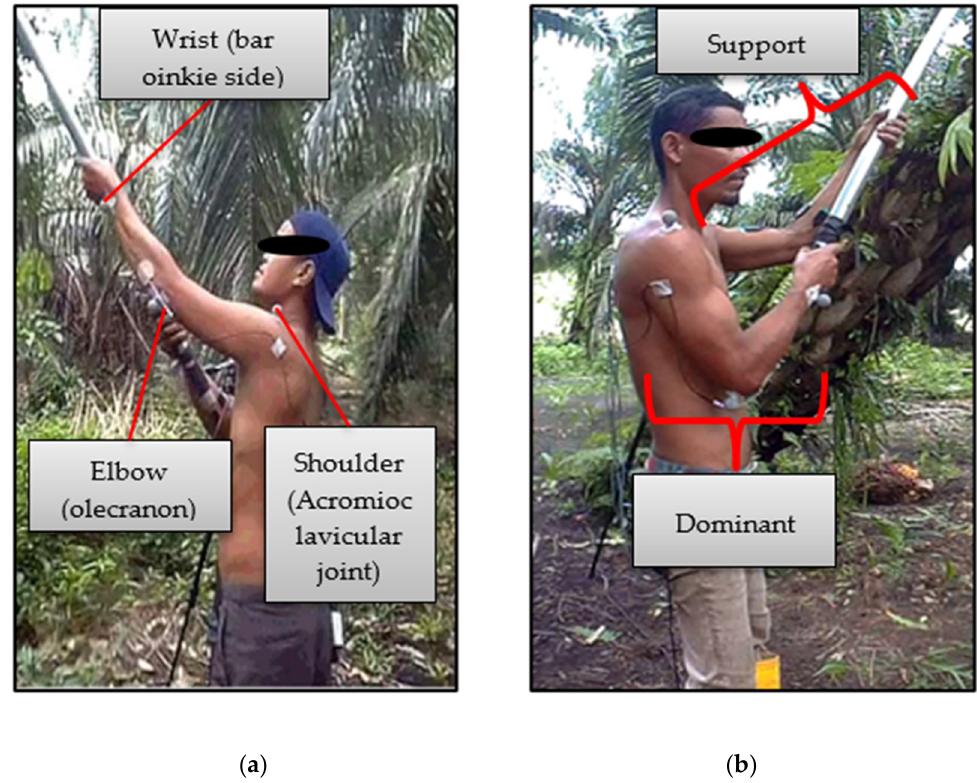
Figure 2. ( a ) The dominant and support arms. ( b ) The anatomical landmarks placed on the partici- pants at their initial posture from the sagittal plane view.